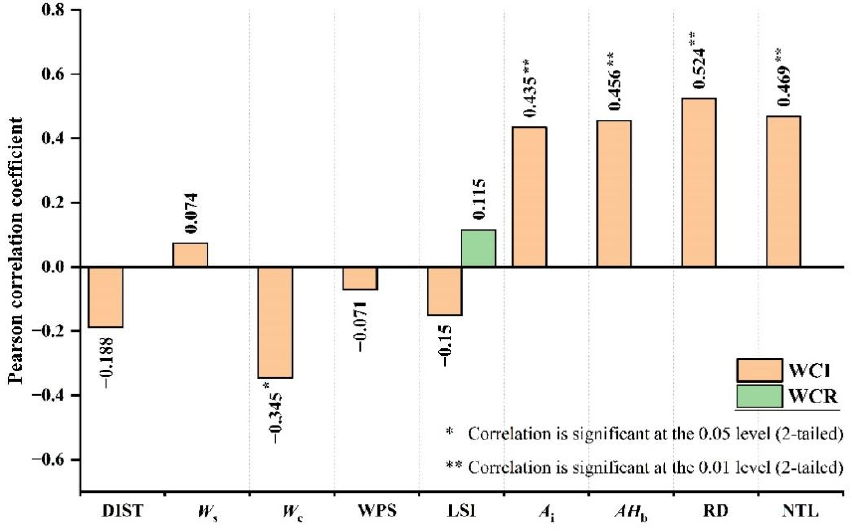
Figure 8. Pearson correlation coefficients between WCI , WCR , and influencing factors.